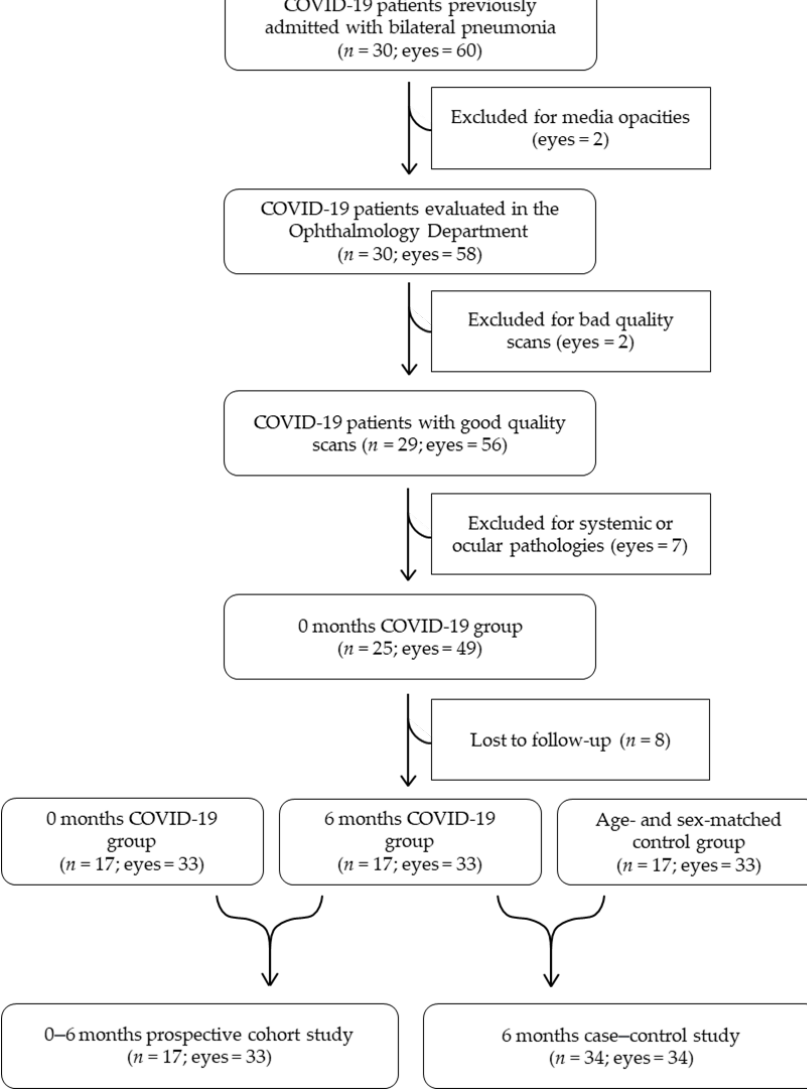
Figure 1. Consolidated standard for reporting trials (CONSORT)-style flow chart describing included and excluded eyes in both the case–control study and the 0–6 months prospective cohort study.